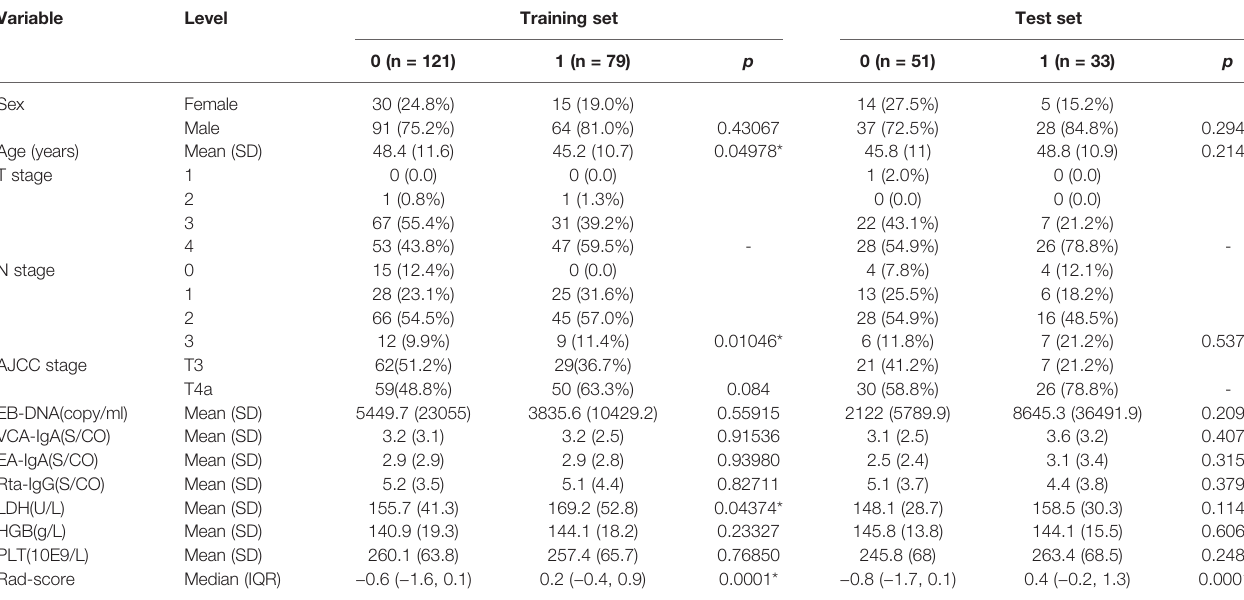
TABLE 1 | Clinical features of patients randomly assigned to the T2-weighted imaging (T2WI) sequence group. Variable Level Training set Test